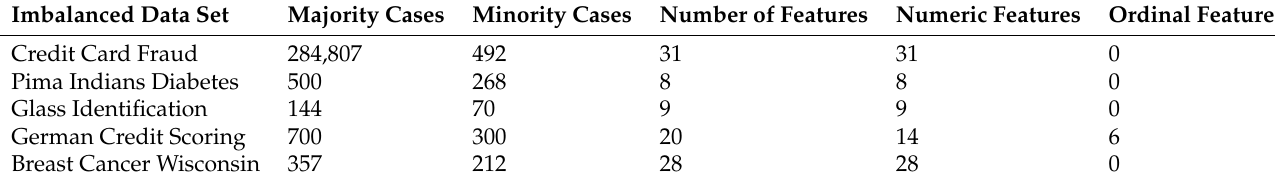
Table 3. Imbalanced data sets used in the